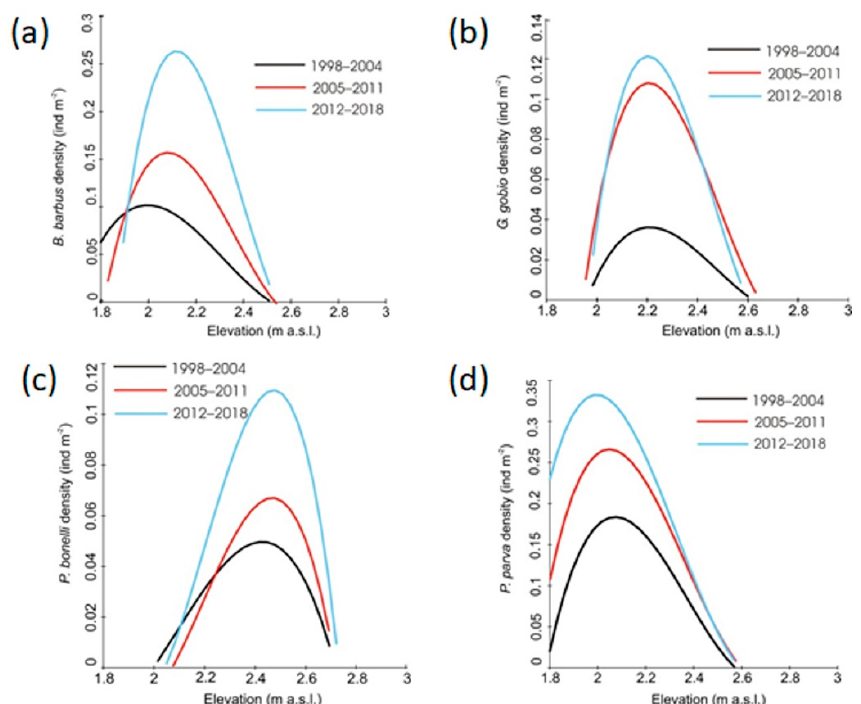
Figure 9. The effects of elevation on the density of ( a ) B. barbus , ( b ) G. gobio , ( c ) P. bonelli and ( d ) P. parva over the census periods 1998–2004, 2005–2011, 2012–2018. Solid lines indicate significant results from the general linear model (GLM).